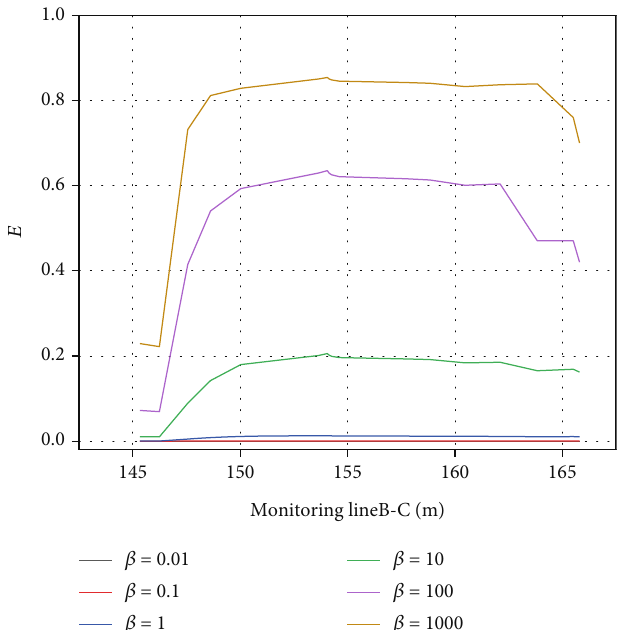
Figure 9: E of fault zone BC at di ff erent permeability